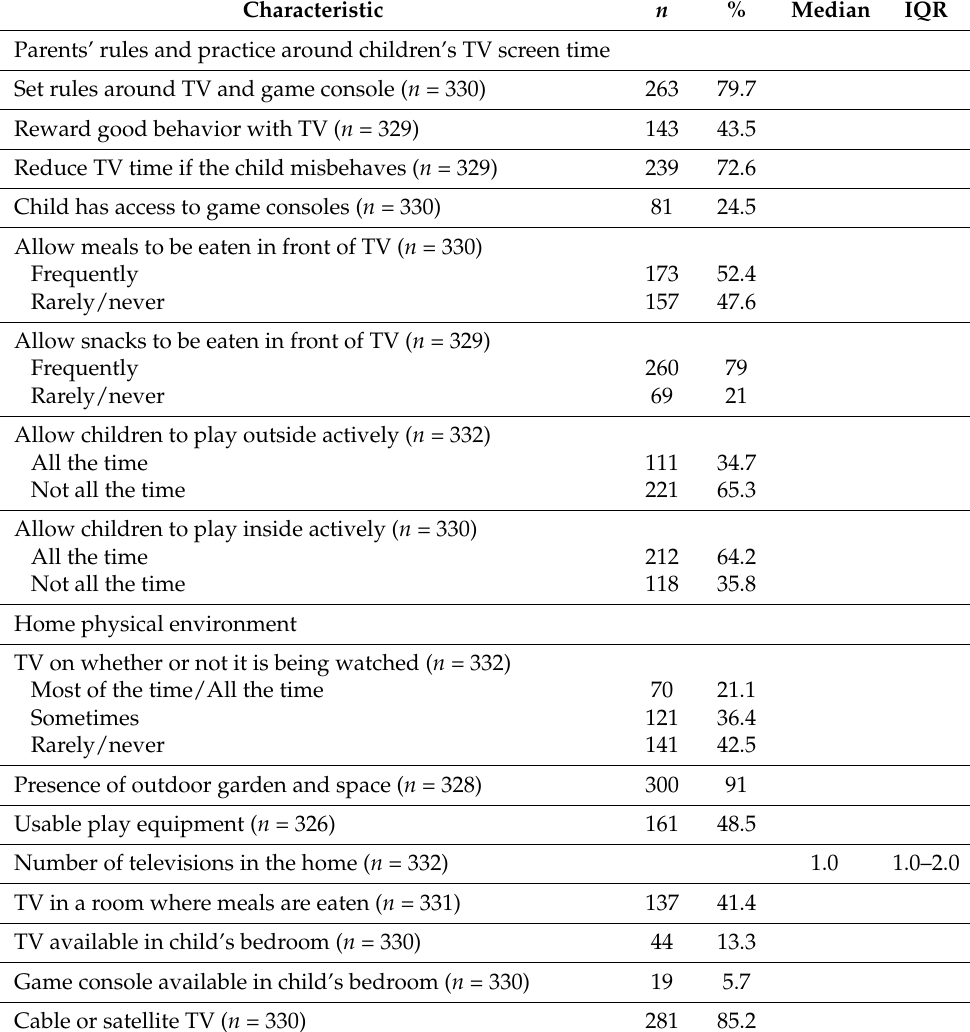
Table 2. Home environmental characteristics: Parents’ rules and practices and home physical